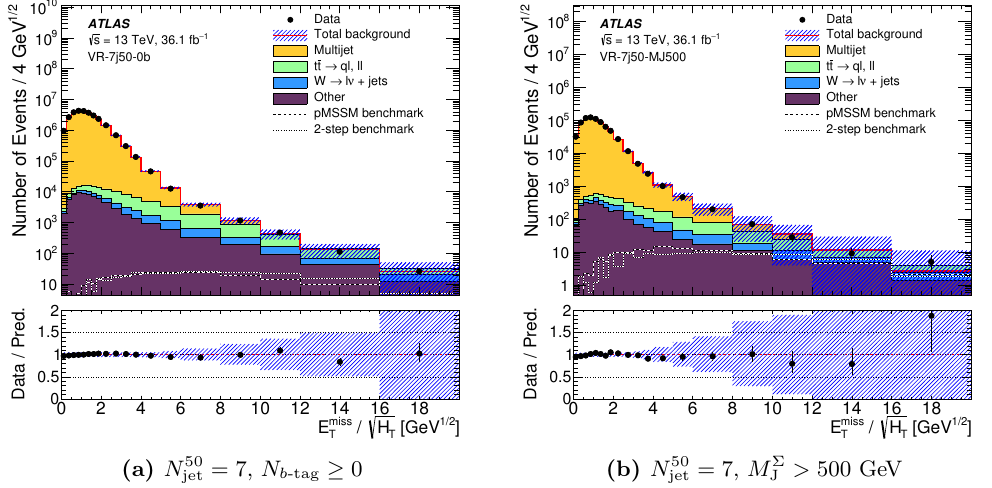
p Figure 2. Distributions of the E miss = H T for events in the validation regions for the 50 GeV jet p T T threshold in the heavy-(cid:13)avour channel (a) and a M (cid:6) selection (b). The blue hatched band indicates J the quadrature sum of the statistical uncertainty from MC simulated samples and the various sys- tematic uncertainties in the background prediction. The dashed lines labelled ‘pMSSM’ and ‘2-step’ refer to benchmark signal points | a pMSSM slice model with ( m ~ g ; m ) = (1400 ; 200) GeV and ~ (cid:31) (cid:6) 1 a cascade decay model with ( m ~ g ; m ) = (1400 ; 200) GeV. The lower panels show the ratio of the ~ (cid:31) 0 1 observed data to the total SM